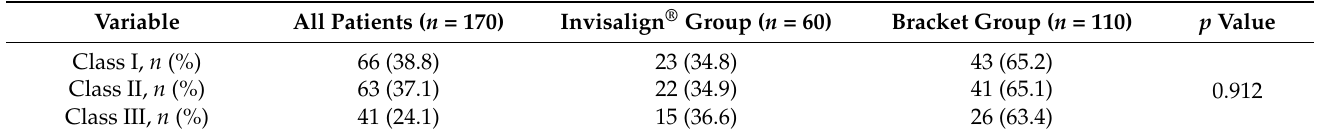
Table 4. Malocclusion type of patients, stratified by orthodontic device (Invisalign ® or bracket) ( n =